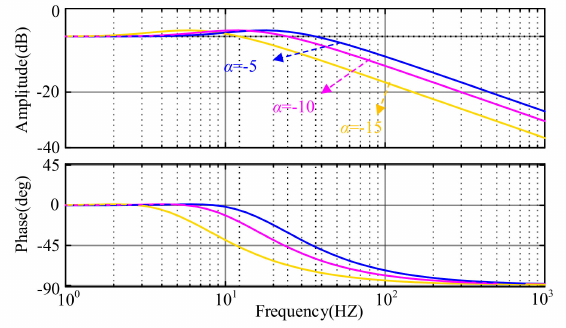
Figure 8. Bode diagram of LBO transfer function.